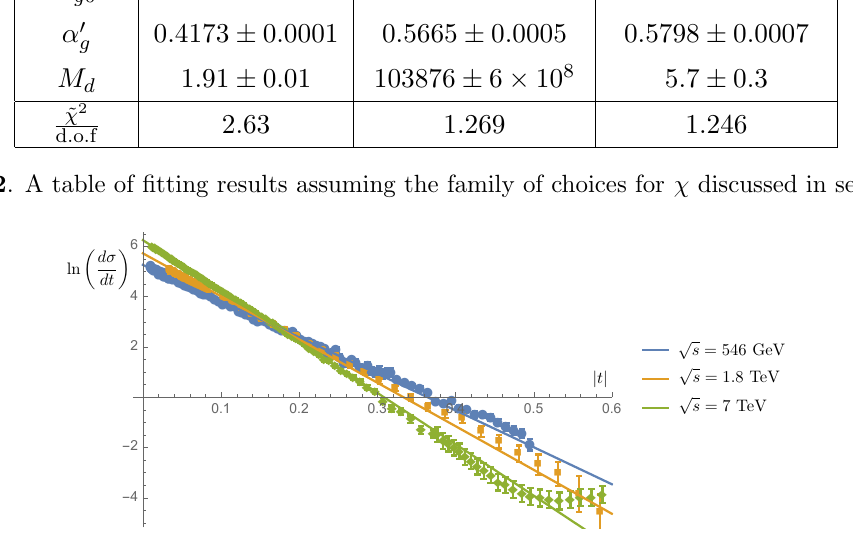
Figure 7 . The data (displayed on a log plot) together with the model for the (cid:12)tting results using equation (5.9) with k = (cid:0)